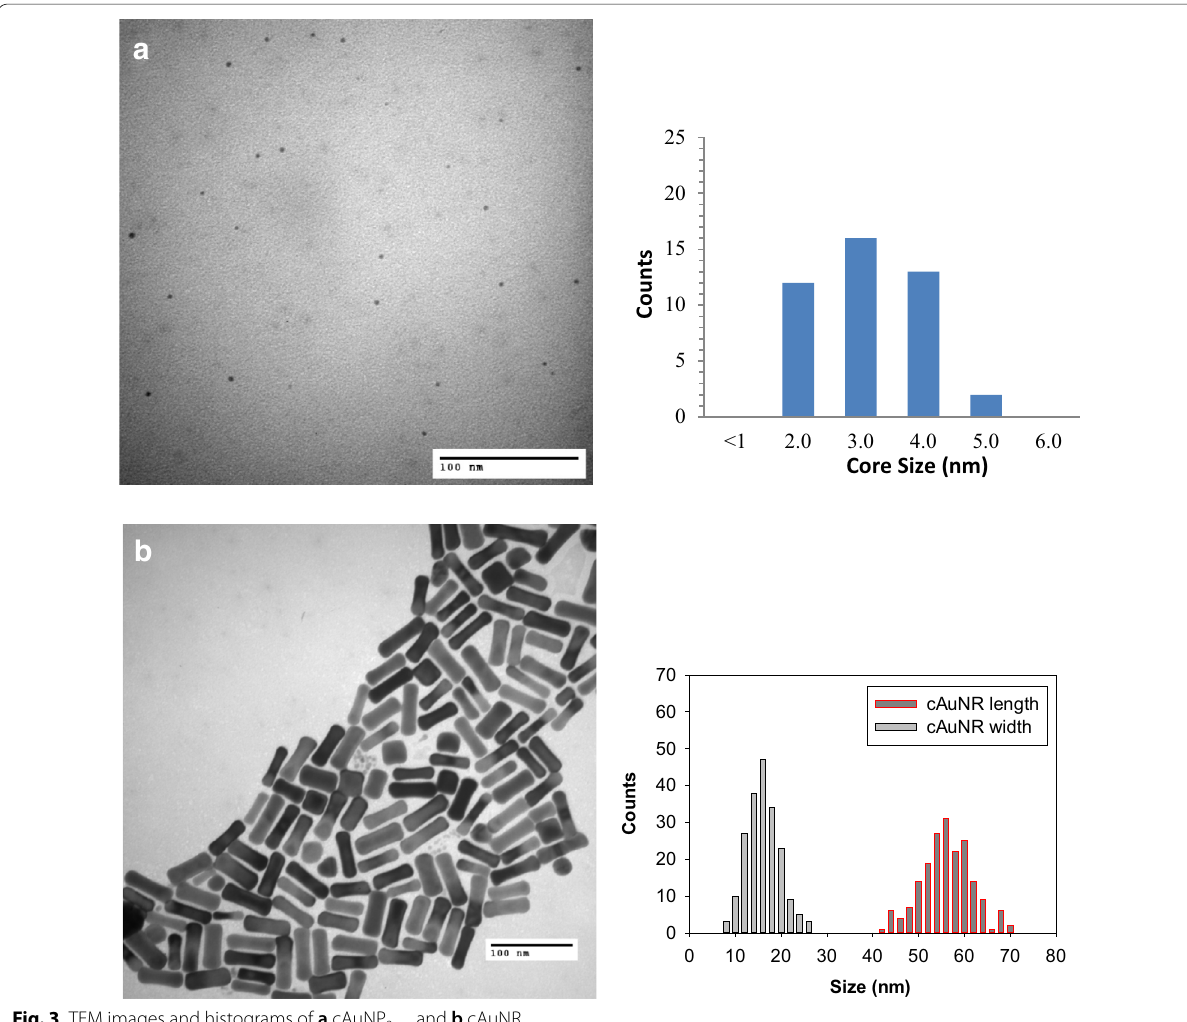
Fig. 3 TEM images and histograms of a cAuNP 3nm and b cAuNR